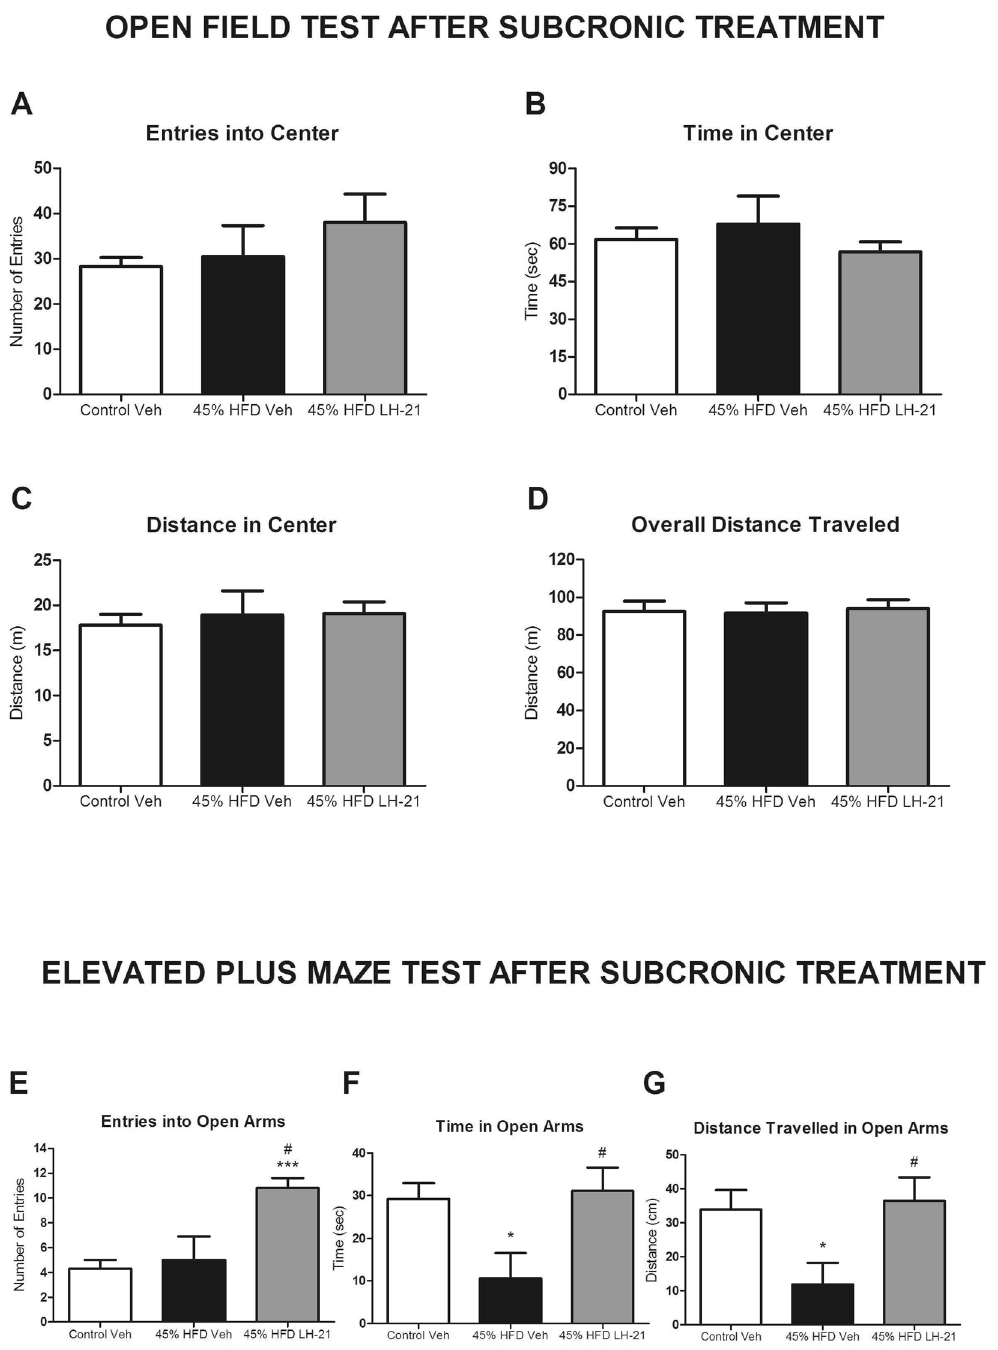
Figure 5. Behavioural study in obese pre-diabetic mice subchronically treated with LH-21. ( A – D ) Exploratory activity was recorded for ten minutes in the open field maze in control, 45% HFD-vehicle and 45% HFD-LH-21 mice. Entries into center ( A ), time in center ( B ), distance in center ( C ) and overall distance travelled ( D ) were monitored. No changes among groups were detected. ( E – G ) Anxiety was analysed by the elevated plus maze test in these mice. Entries into open arm ( E ), time in open arms ( F ) and distance travelled in open arms ( G ) were recorded for five minutes. 45% HFD-vehicle mice showed an anxiety-like behaviour, with decreased time in open arms and distance travelled in open arms when compared to control mice. Subchronic treatment of obese pre-diabetic mice with LH-21 induced an anxiolytic-like behaviour with increased number of entries into open arms and LH-21 reverted the HFD-induced decrease in time in open arms and distance travelled in open arms. n = 8–10 mice each group. One-way ANOVA and Bonferroni’s post-test, * p < 0.05 versus Control-Vehicle, # p < 0.05 versus 45%